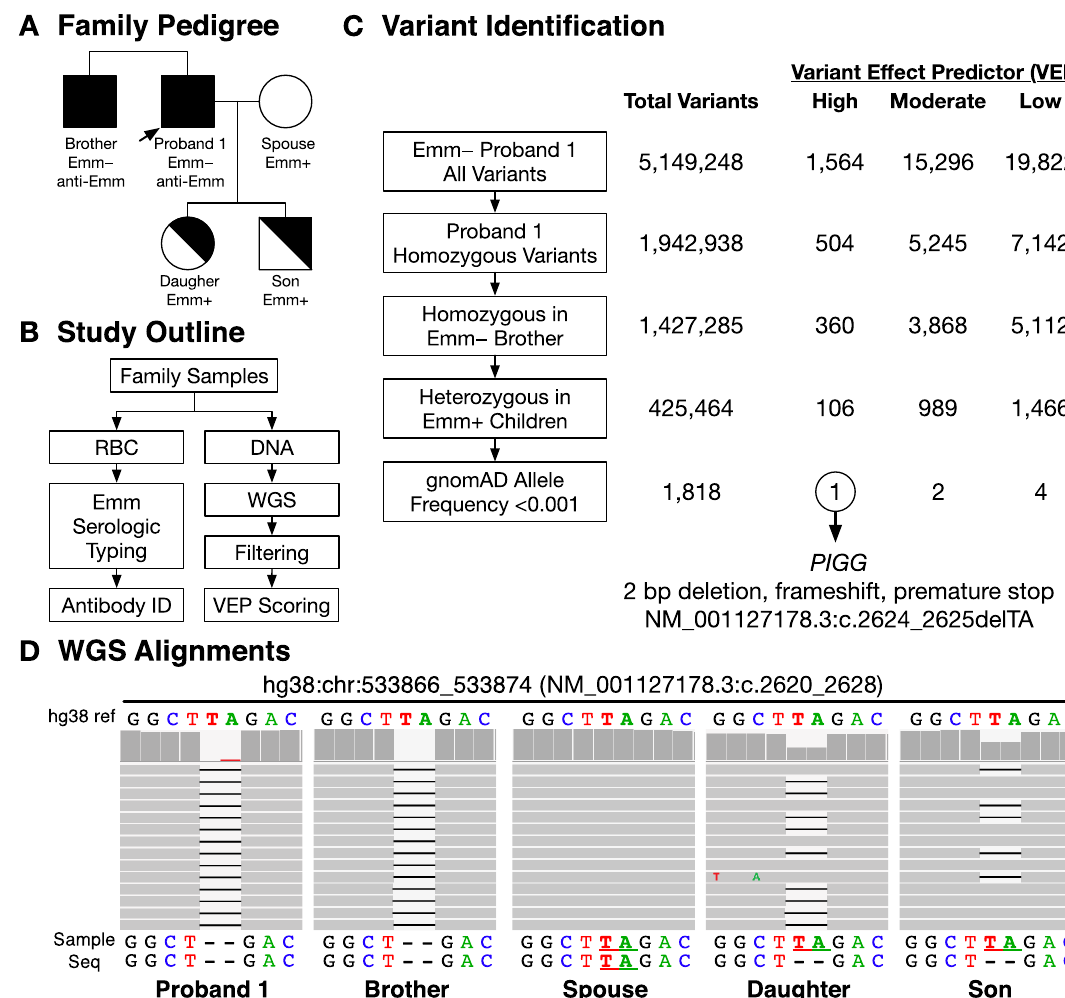
Figure 1. ( A ) Family Pedigree. Emm RBC phenotypes shown include the Proband and his brother (both with anti-Emm in the plasma). Also shown are the Proband’s spouse and two children who are Emm+ and were shown to lack the antibody. ( B ) Study Outline. Emm serologic RBC typing was performed with in-house reagents and short read whole genome sequencing (WGS). ( C ) Variant Identification. Illustration of the strategy used to enrich for loss of function mutations associated with familial inheritance and variant effector prediction (VEP) scoring to identify the genetic cause of the Emm− phenotype. PIGG was the only candidate gene that passed our filtering strategy. ( D ) WGS alignments. IGV genomics viewer shows the wild type sequence (upper) and PIGG Exon 12 biallelic sequence for each family member (below). Individual sequence reads are shown in gray for positions corresponding to the hg38 reference sequence with bar plots above (dark grey) reflecting the relative number of reads at that position. Emm− family members were homozygous for a 2-bp deletion in Exon 12, predicted to cause a frameshift and premature stop, designated in as c.2624_2625delTA, p.(Leu875*), rs771819481, and chromosomal location hg38:chr4:533870_533871delTA. The spouse was wild type, and the daughter and son are